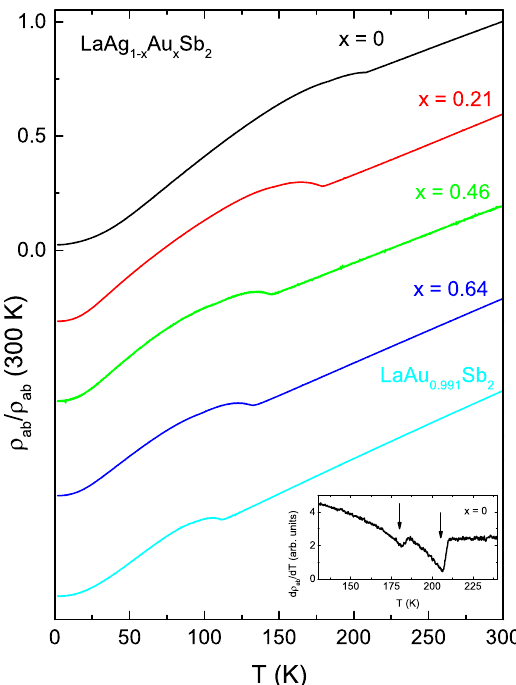
Figure 5. Normalized in-plane resistivity for LaAg 1 − x Au x Sb 2 . Data are vertically shifted for clarity. The curve for LaAu 0.991 Sb 2 [17] is added for the reference. The inset shows an example of d ρ ab / dT for LaAgSb 2 with two CDW transitions marked.